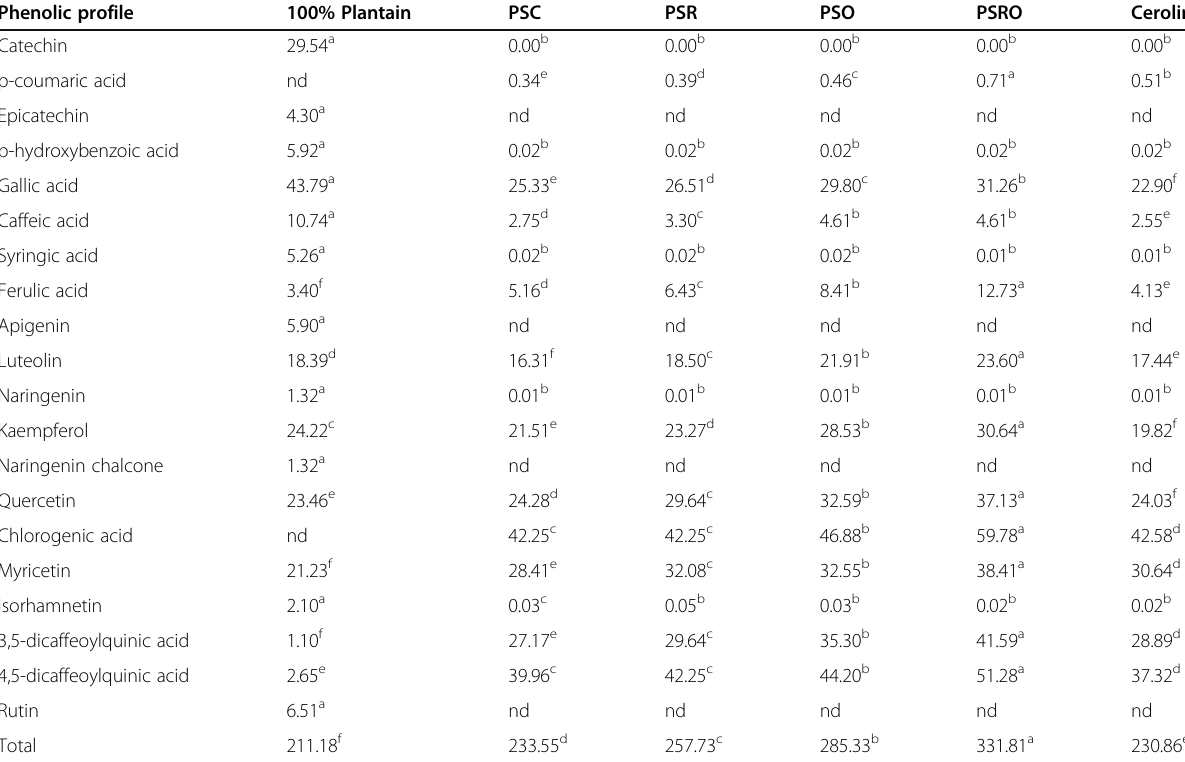
Table 5 Phenolic profile (mg/g) of plantain, soycake, rice bran and oat bran dough meal and control samples Phenolic